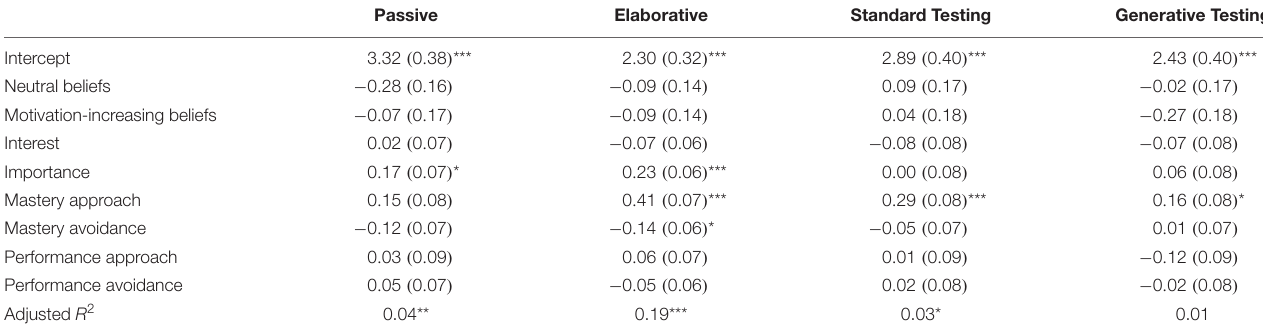
TABLE 7 | Summary of regression coefficients, predicting study strategy use from achievement goals, controlling for implicit belief profiles, course interest, and course